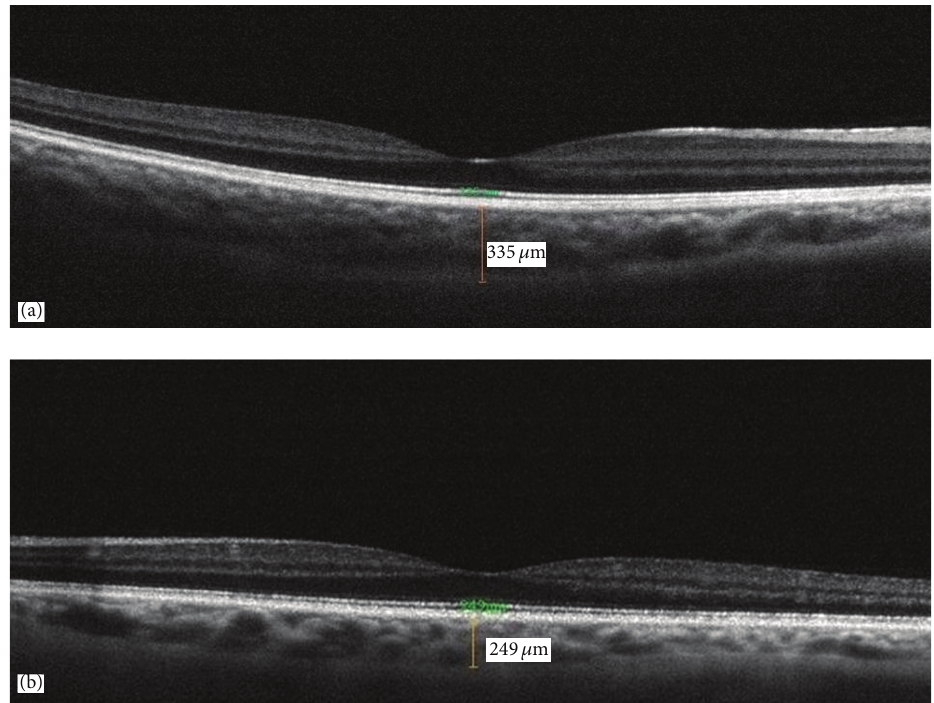
Figure 1: Sixty-four-year-old male patient: (a) 335 𝜇 m subfoveal choroidal thickness in right eye (85% stenosis in right internal carotid artery) and (b) 249 𝜇 m subfoveal choroidal thickness in left eye (55% stenosis in left internal carotid artery).